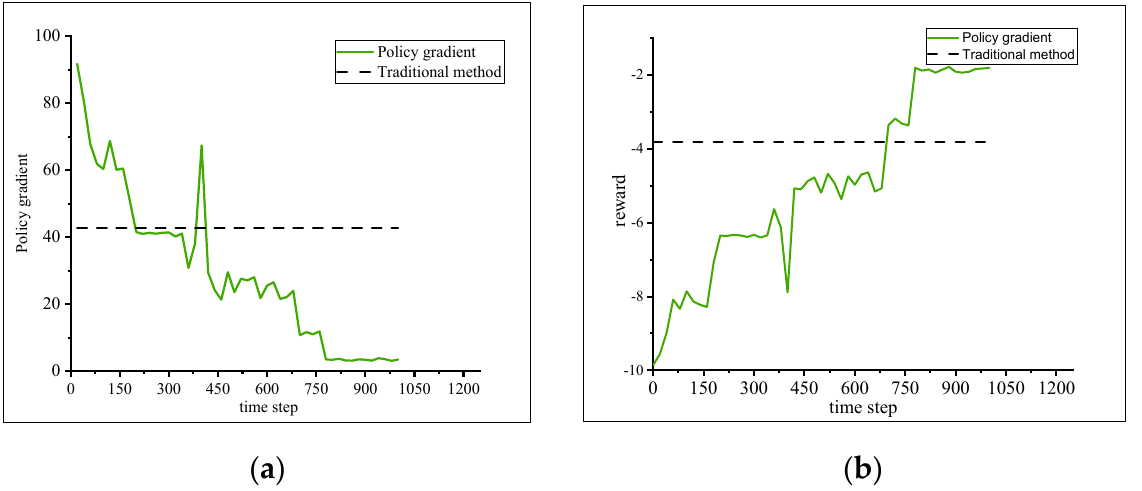
Figure 5. PG algorithm and traditional algorithm cost function graph . ( a ) Collision loss convergence; ( b ) reward convergence.